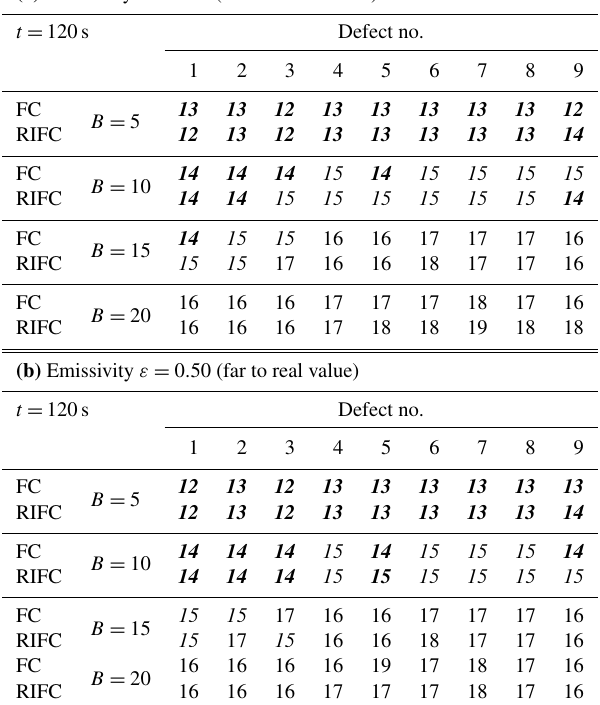
Table 2. Evaluated horizontal dimension of defects from segmented thermogram with local thresholding, measured in pixels. The values which vary from the real size by not more than 1 pixel, i.e. [12, 13, 14], have been additionally highlighted in bold